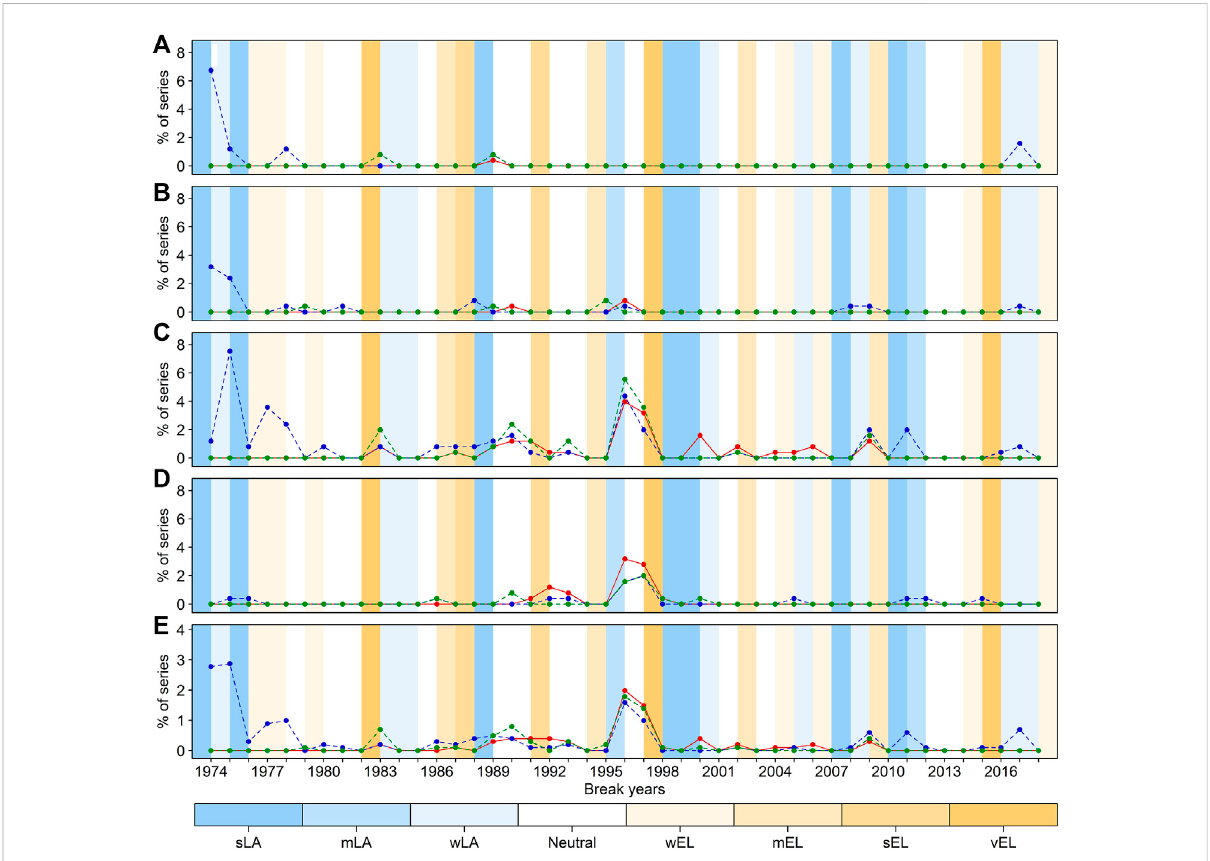
FIGURE 3 Percentage of series with break years related to (A) RR, (B) RX, (C) DD, (D) DPX, and (E) Total for the Pettitt test (red line), Standard normal homogeneity test SNHT (blue line) and Buishand test (green line) from 1974 to 2018. The bluish colors refer to the La Niña (LA) events, and the yellowish ones refer to the El Niño (EL) events, with weak (w), moderate (m), strong (s), and very strong (v)